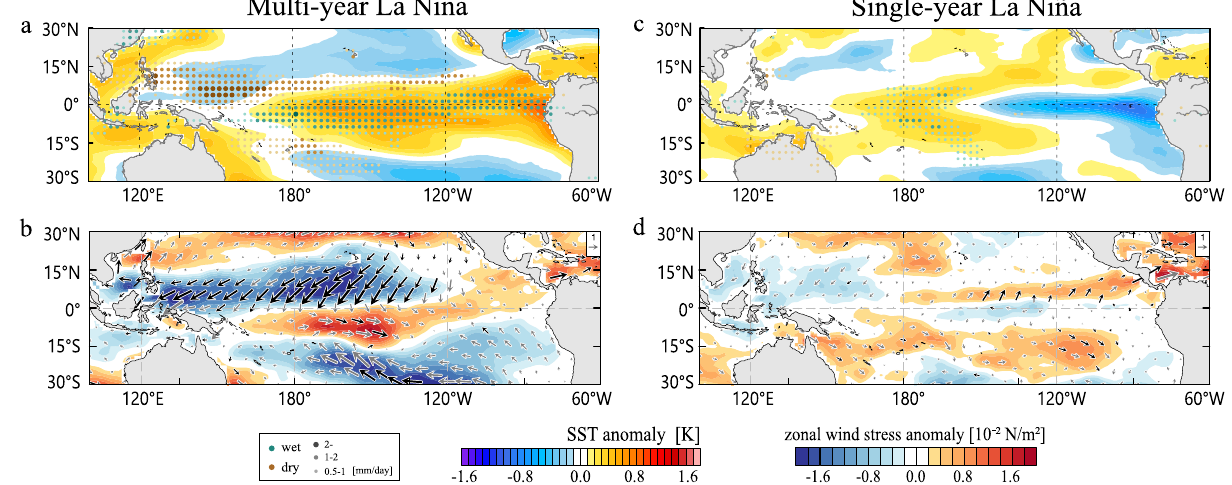
Figure 3. Multi-year and single-year La Niña composite maps in FMAMJ(0). ( a ) Anomalous SST (shading) and precipitation (dots) and ( b ) surface zonal wind stress (shading) and wind stress vector (unit in 10 −2 N/m 2 ) for the multi-year La Niña composite. ( c , d ) As in ( a , b ) but for the single-year La Niña composite. Vectors in black indicate anomalies statistically significant at the 95% confidence level. (Maps are generated by